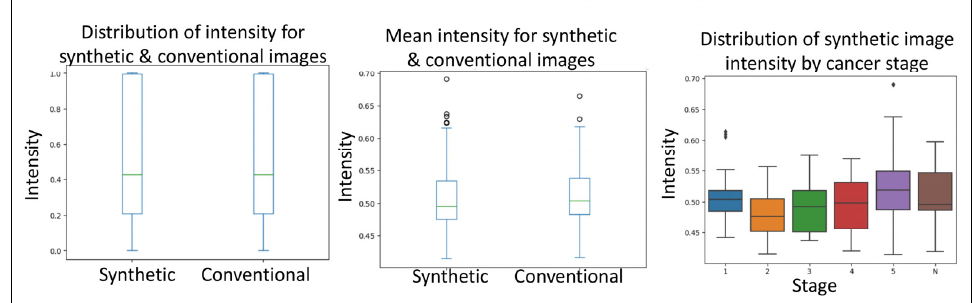
Figure 3. Boxplots depicting the minimum, median, interquartile range, maximum and potential outliers of image intensity for both synthetic and conventional samples. Highlighting the convolu- tional neural network quality control and applicability validation steps in evaluating the distribution of intensity for synthetic and conventional images, mean intensity for synthetic and conventional images, and distribution of synthetic image intensity by cancer stage. Here “N” represents normal and 1–5 represents the increasing progression of the